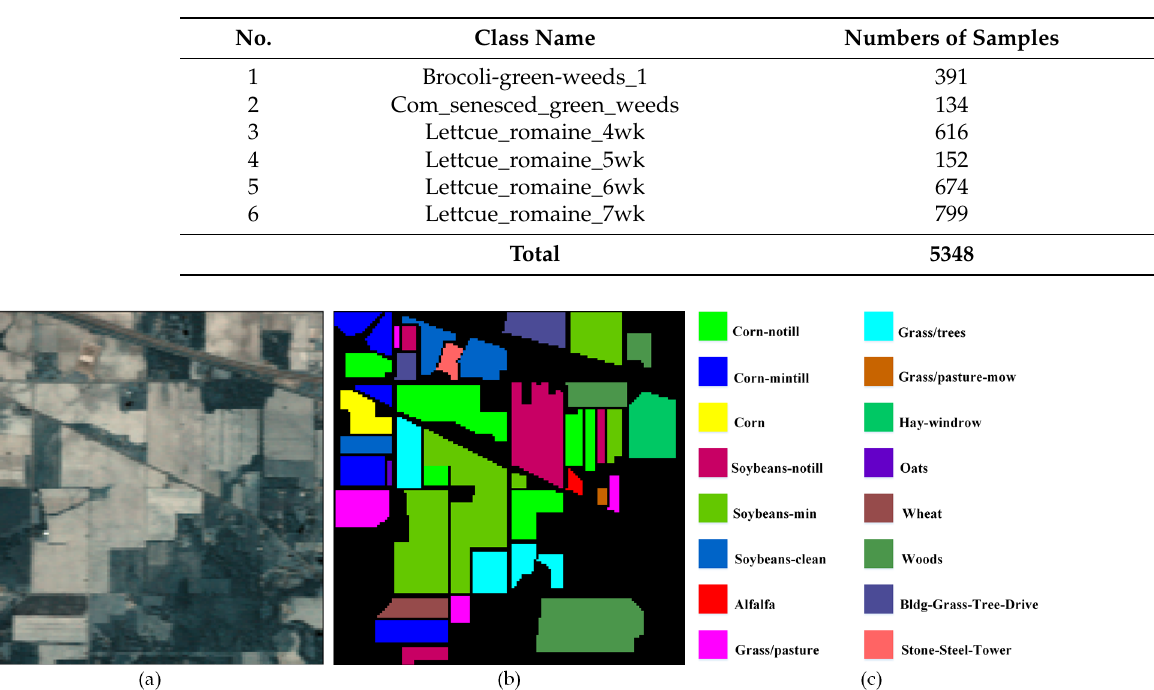
Table 3. Land cover class information for the SA dataset.